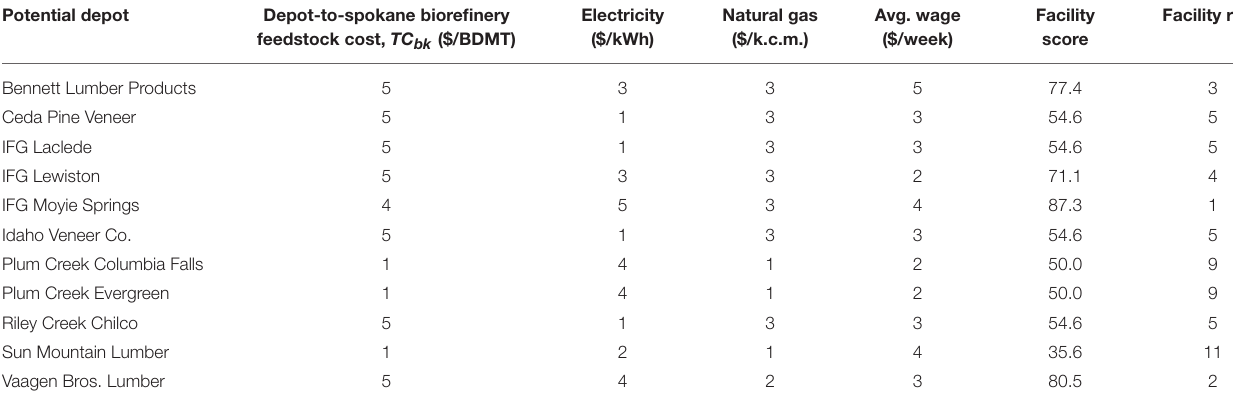
TABLE 5 | Potential depot scaled values for spokane biorefinery supply chain. Potential